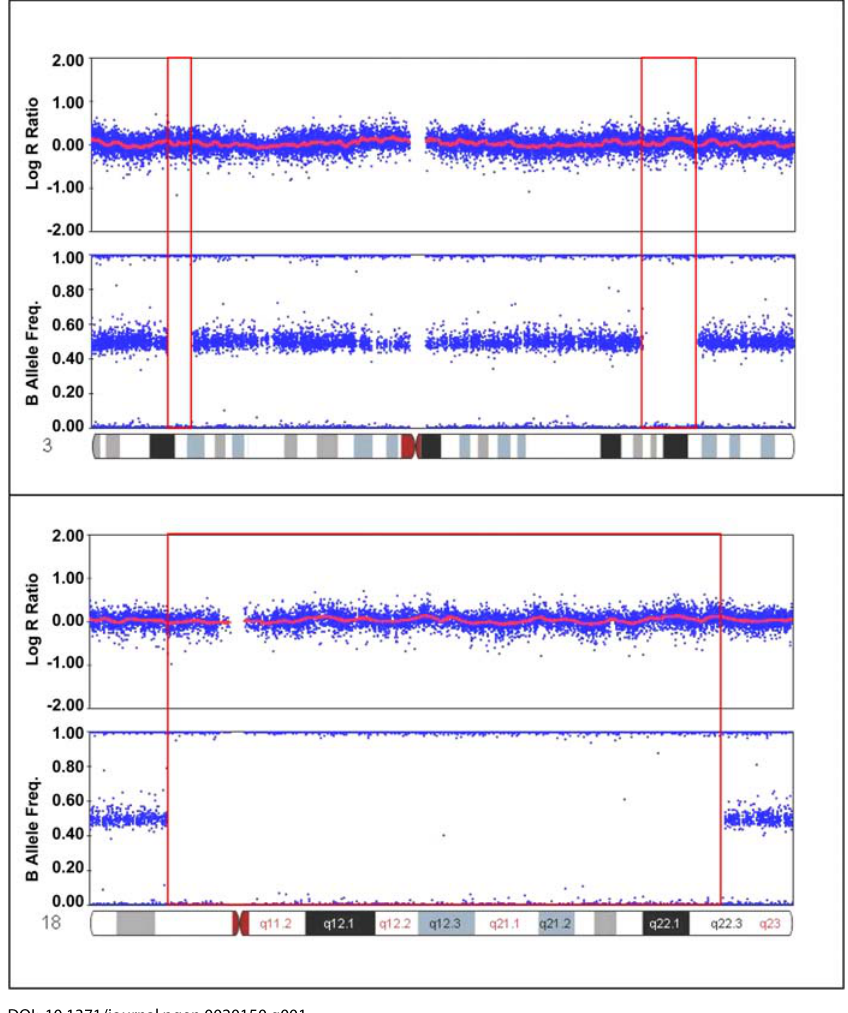
Figure 1. Multiple Regions of Extended Homozygosity within a Single Subject Born from a First Cousin Marriage The regions of extended homozygosity on Chromosomes 3 (upper panel) and 18 (lower panel) are outlined in red. Homozygosity is shown by a lack of A/B genotype calls (corresponding to a B allele frequency of 0.5) coupled with a normal copy number, indicated by an average log R ratio of 0.